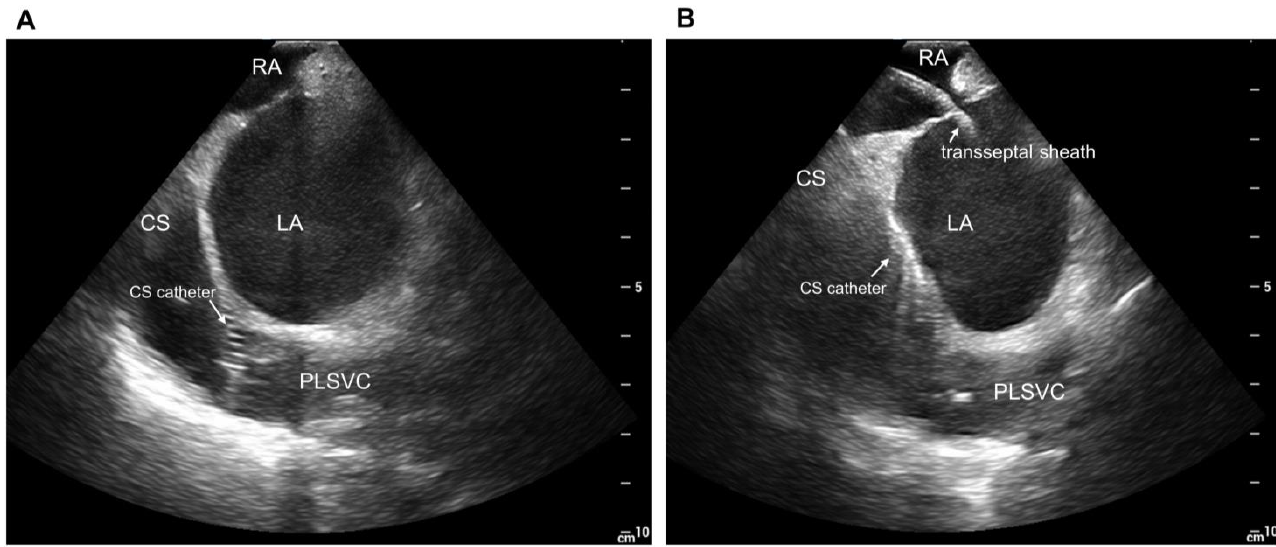
Figure 2. Intracardiac echocardiographic views. ( A ): Duodecapolar catheter inside the PLSVC from dilated CS. ( B ): View of the PLSVC after the transseptal puncture. CS, coronary sinus; LA, left atrium; RA, right atrium; PLSVC, persistent left superior vena cava.